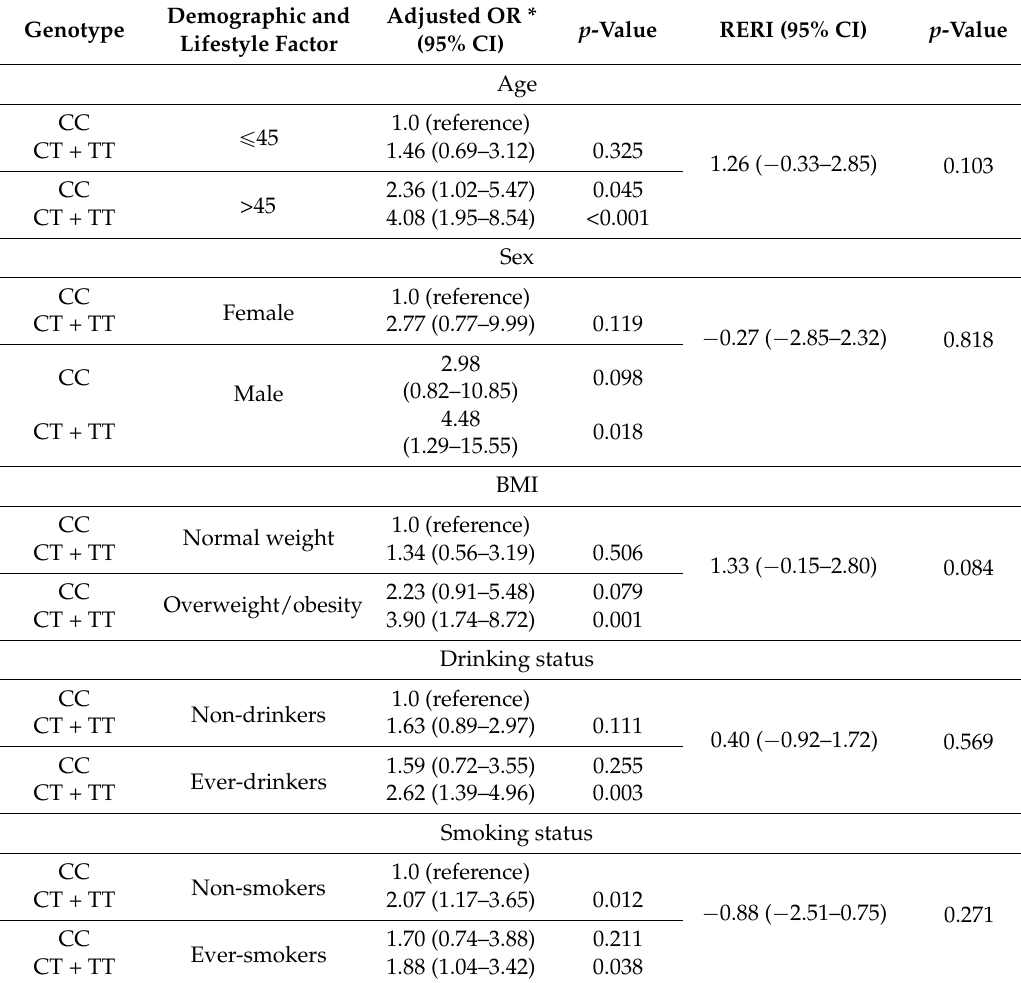
Table 4. Interaction effects of the MTHFR C677T polymorphism with age, sex, BMI, drinking, and smoking status on hypertension